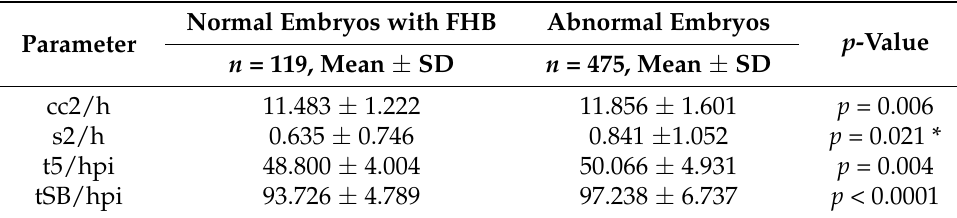
Table 2. Comparison of morphokinetic parameters in groups of PGT-A normal embryos with achieved clinical pregnancy and abnormal embryos.